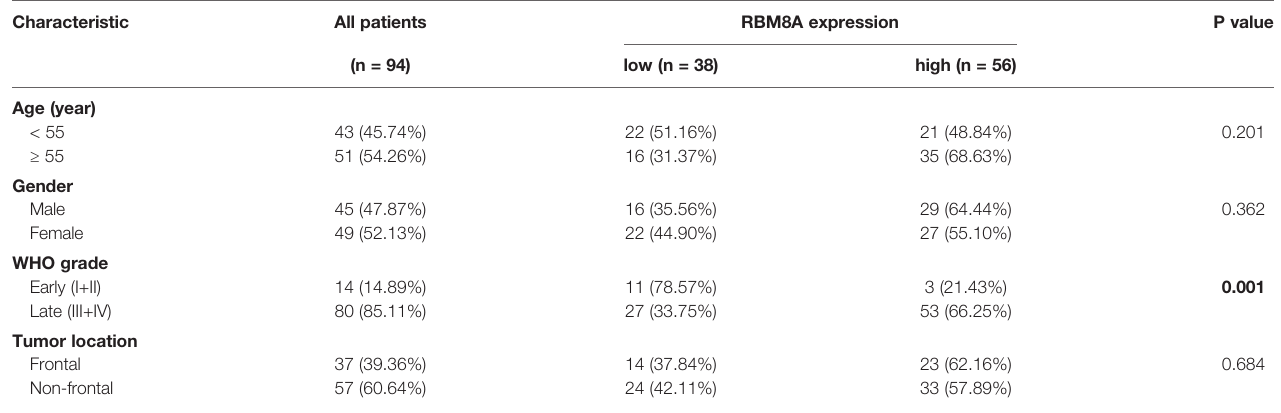
TABLE 1 | Clinicopathological characteristics of patients strati fi ed by RBM8A expression level.